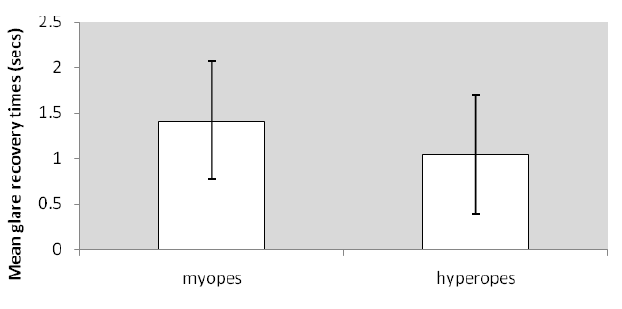
Figure 2: Mean glare recovery times of myopic and hyperopic eyes.